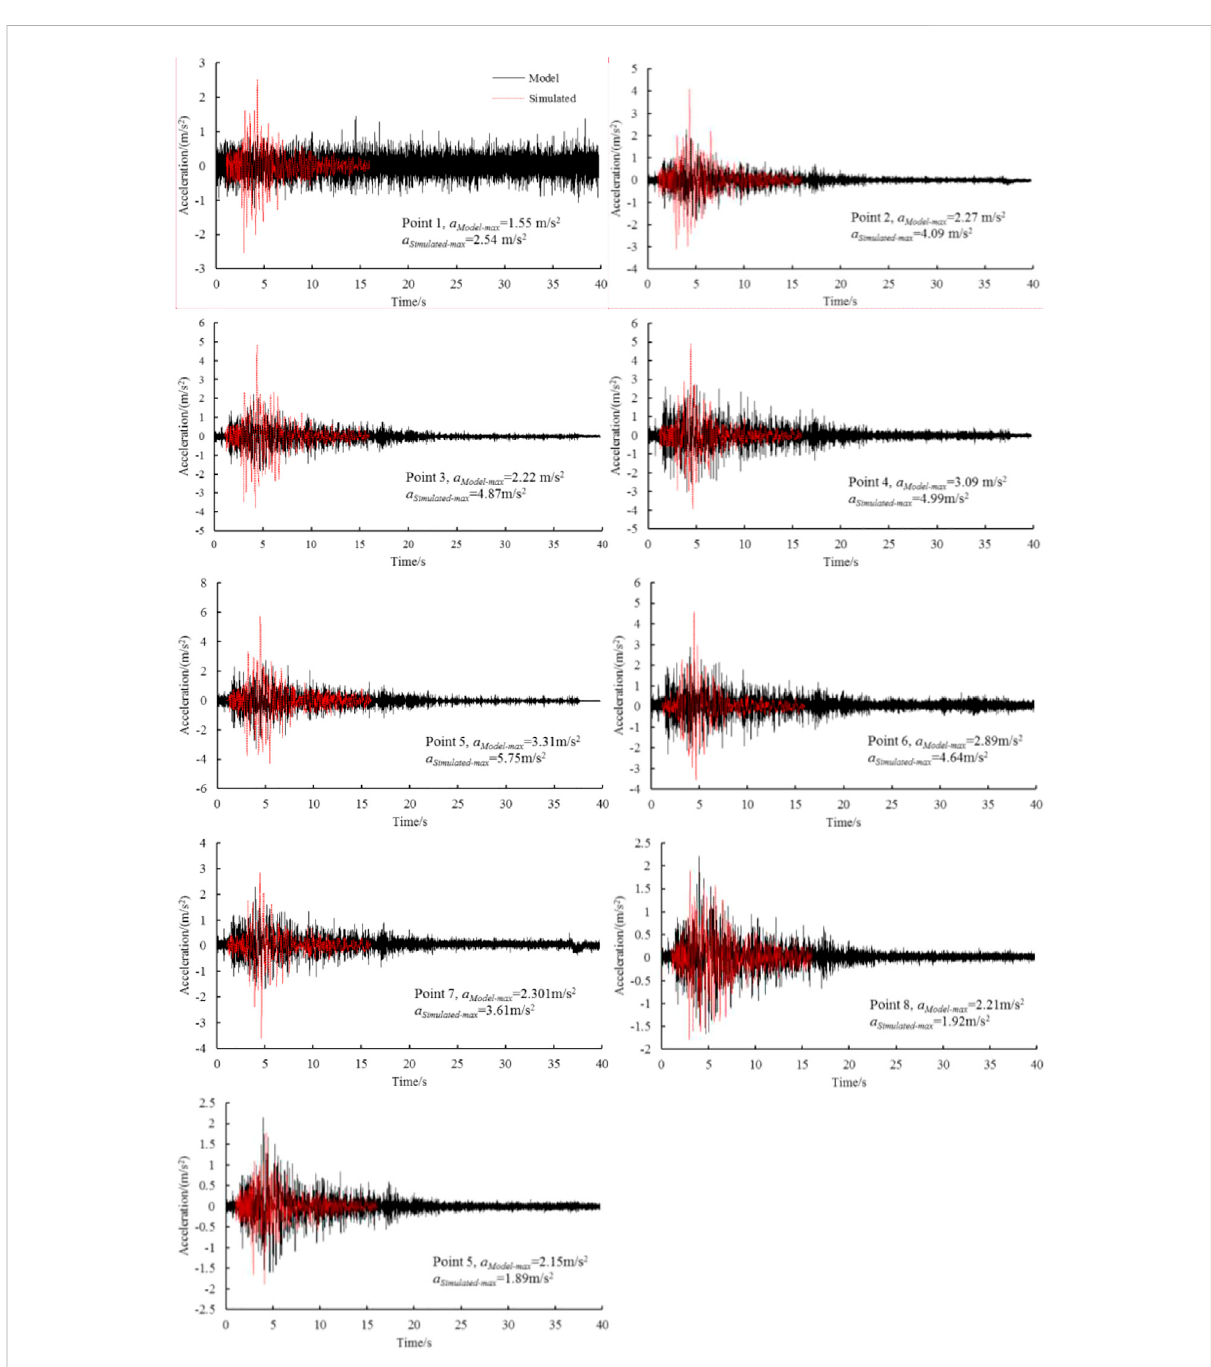
FIGURE 12 Time course of horizontal ground-motion acceleration ateach measuring point ofthe slope under seismic waveexcitation with apeak ground acceleration (PGA) of 183.2 gal used in the model test and numerical simulation.